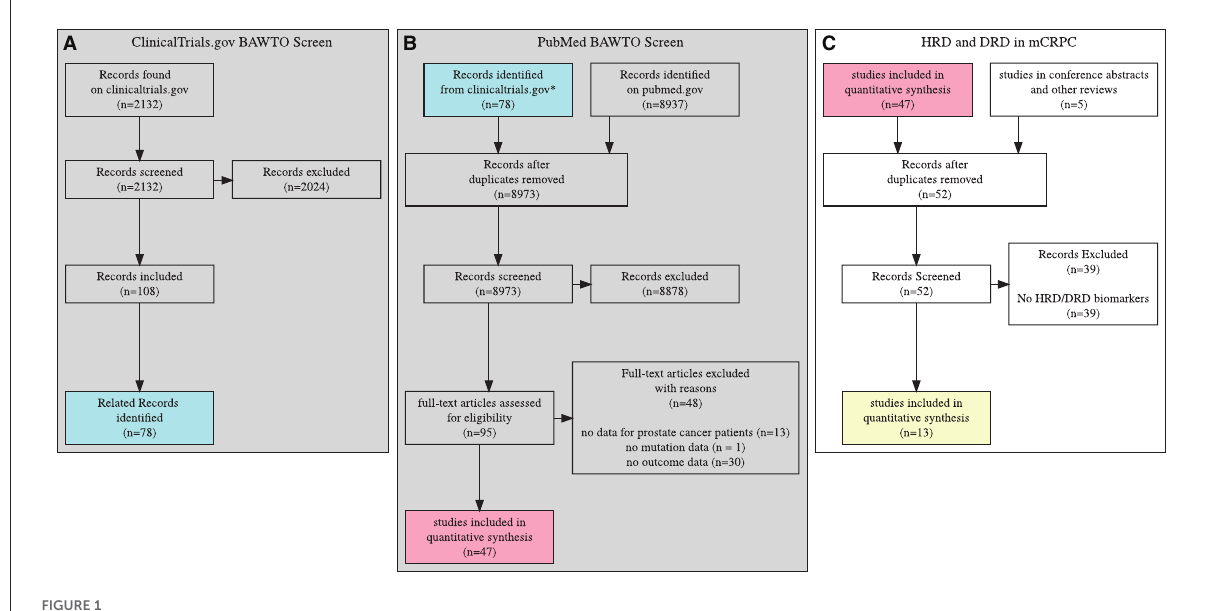
FIGURE1 3 stage prisma diagram, gray diagrams indicate screens completed in the BAWTO project. Shared colors indicate equivalent sets. (A) Clinicaltrials.gov documents screened in the BAWTO project. (B) Publications derived from pubmed or from (A) are screened in the BAWTO project. (C) Studies screened from BAWTO and other sources for reference to HRD/DRD